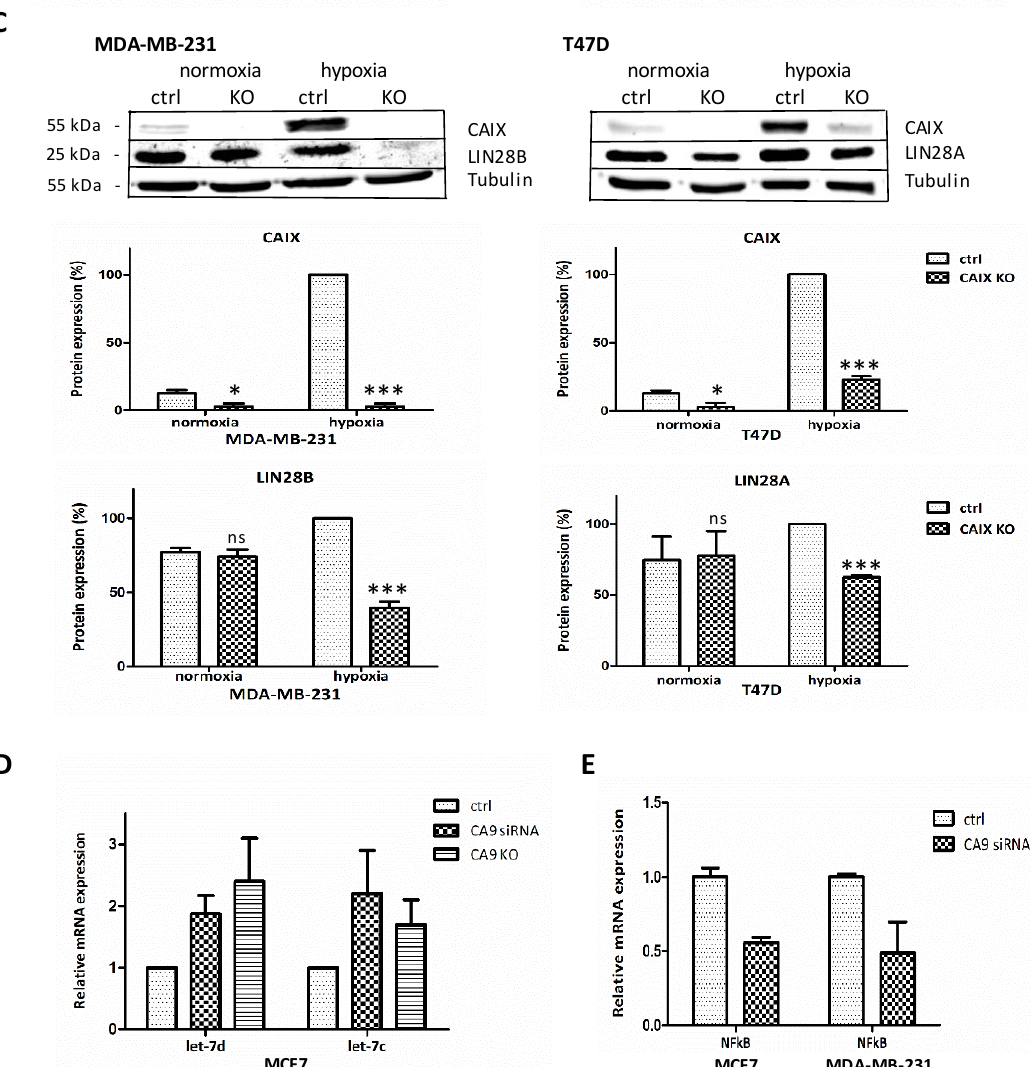
Figure 1. CAIX suppression a ff ects LIN28 expression. ( A ) Representative Western blot of normoxic and hypoxic MCF7 cells transiently transfected with siRNA-control / siRNA-CA9, detecting CAIX, actin, and LIN28. Signal intensities from three di ff erent immunoblots were quantified using the ImageJ software, normalized to actin, and presented as an average percentage of hypoxic control-siRNA ( = 100%). ( B ) Quantitative PCR analysis of CA9 and LIN28 mRNA expression in hypoxic CA9 -silenced cells normalized to actin, presented as a percentage of the expression in cells transfected with control-siRNA (siCtrl = 100%). The results represent the mean of three independent biological experiments done in triplicates. ( C ) Representative Western blot of CAIX and LIN28 (homolog B for MDA-MB-231, homolog A for T47D) in MDA-MB-321-CA9-KO and T47D-CA9-KO cell lines. Average signal from 3 di ff erent Western blots quantified by the ImageJ software, normalized to tubulin, and presented as a percentage of hypoxic control ( = 100%). ( D ) The e ff ect of CAIX-depletion on let-7 expression (qPCR) in MCF7, confirming microarray data presented in Table 1, extended with confirmation in KO